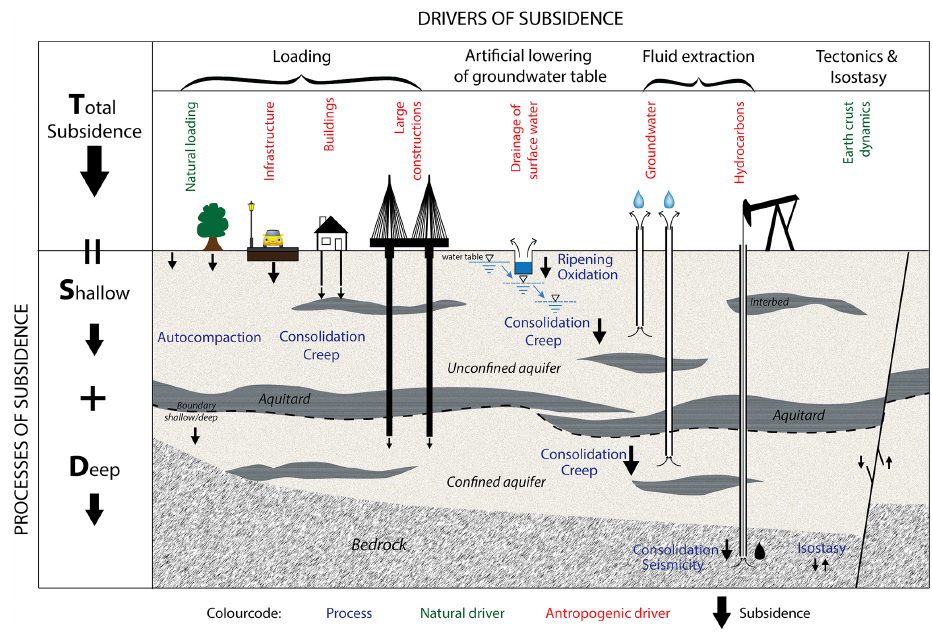
Figure 2. Schematization of the main subsidence drivers and processes within the upper (phreatic) aquifer and deeper (confined) aquifer(s). Natural and anthropogenic drivers are distinguished. The subsidence balance equation is given on the left side, being the total sum of all shallow and deep subsidence rates.